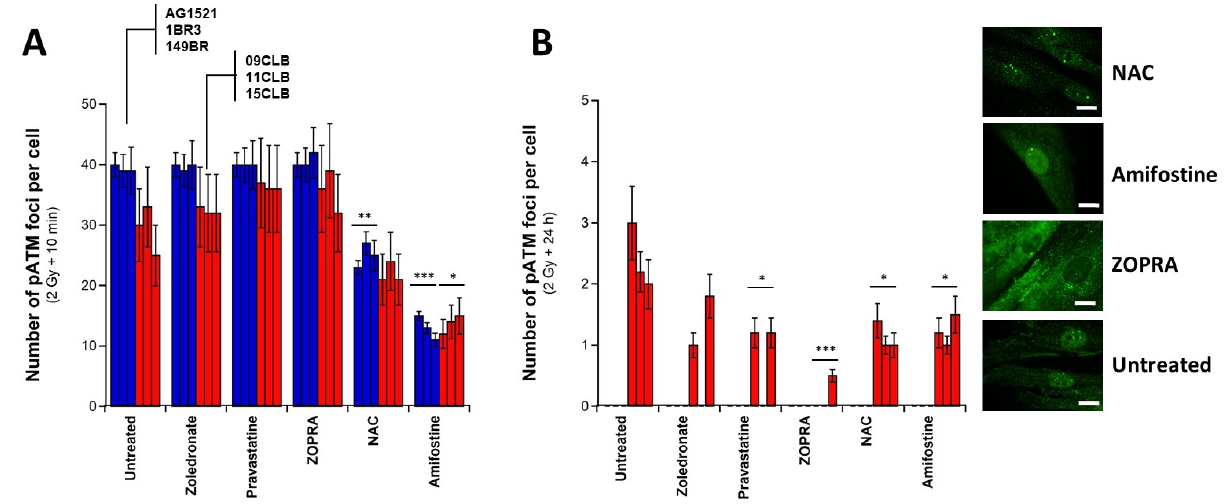
Figure 6. Radioprotective effect of a pretreatment with zoledronate, pravastatine and ZOPRA assessed with pATM foci. Number of pATM foci per cell assessed in the indicated pretreatment and after the indicated pretreatment, followed by 2 Gy X-rays and 10 min ( A ) or 24 h ( B ) incubation. Each point represents the mean ± standard error (SEM) of at least three replicates. Inserts show representative examples of untreated and ZOPRA, 300 mM amifostine and 96 mM NAC pretreated 09CLB nuclei with pATM foci assessed at 24 h post irradiation at the indicated conditions. White bar represents 10 µ m. one, two and three asterisks indicate p < 0.05, p < 0.01 and p < 0.001, respectively, by comparison with the untreated controls.